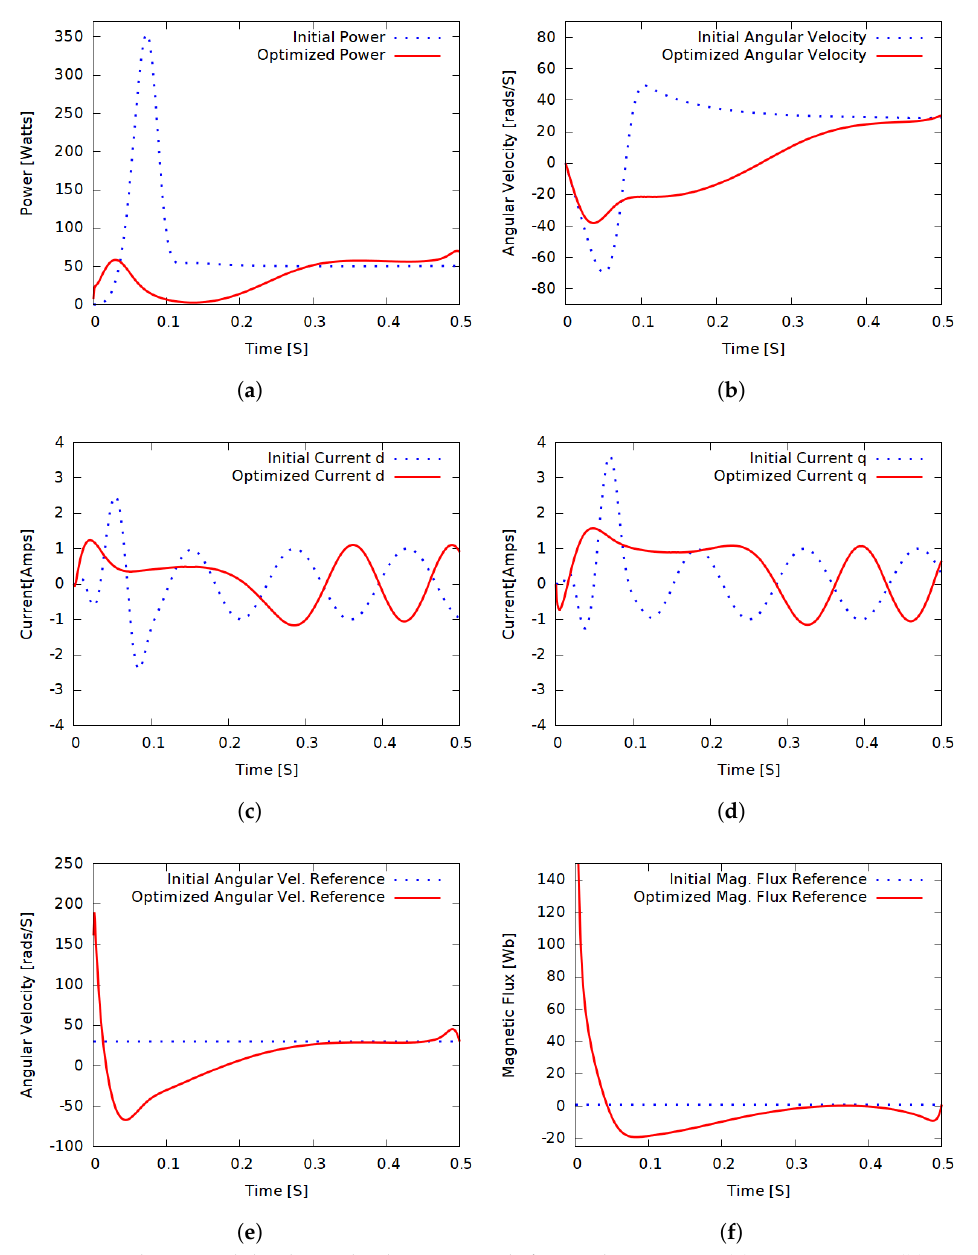
Figure 3. Simulation with load. Final velocity: 30 rads/s. Final time: 0.5 s. ( a ) motor power; ( b ) motor angular velocity; ( c ) motor supply current d -axis; ( d ) motor supply current q -axis; ( e ) angular velocity reference; ( f ) magnetic flux